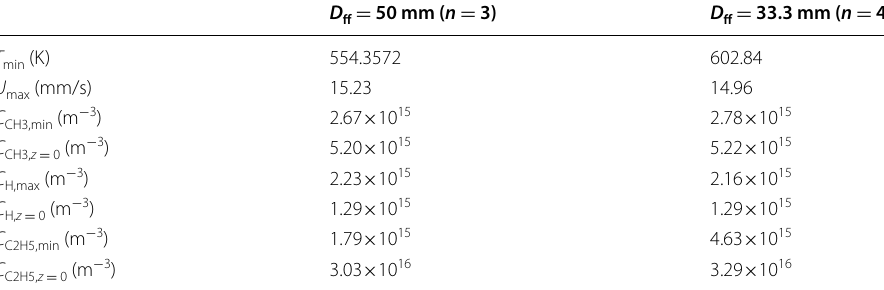
Table 4 Effect of the number of filaments on